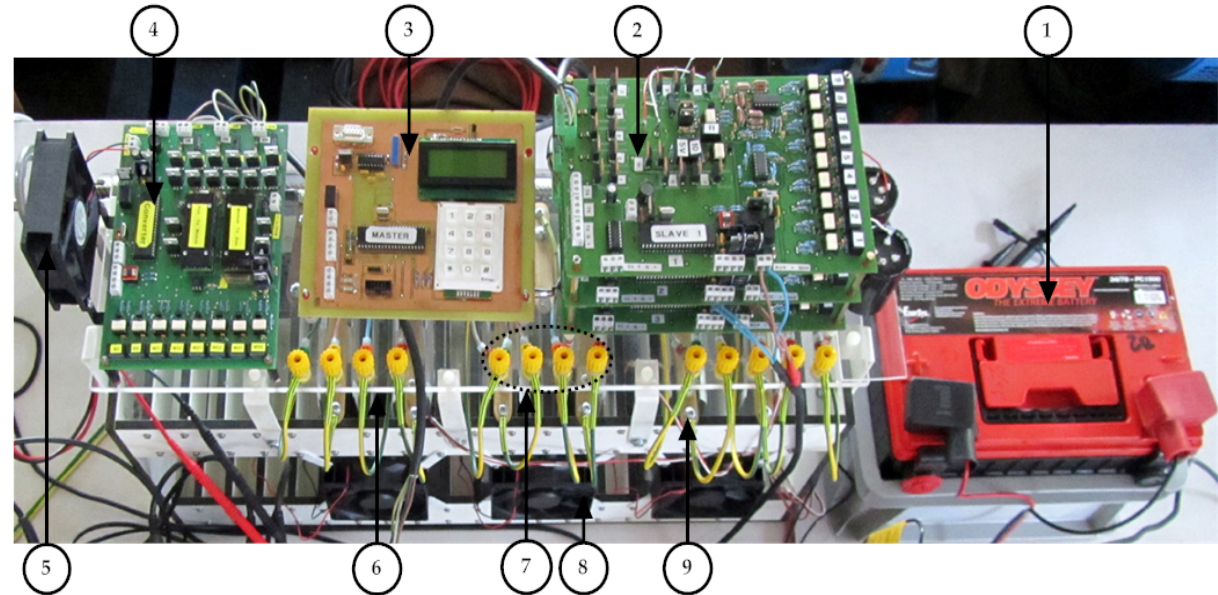
Figure 14. Battery pack experimental prototype